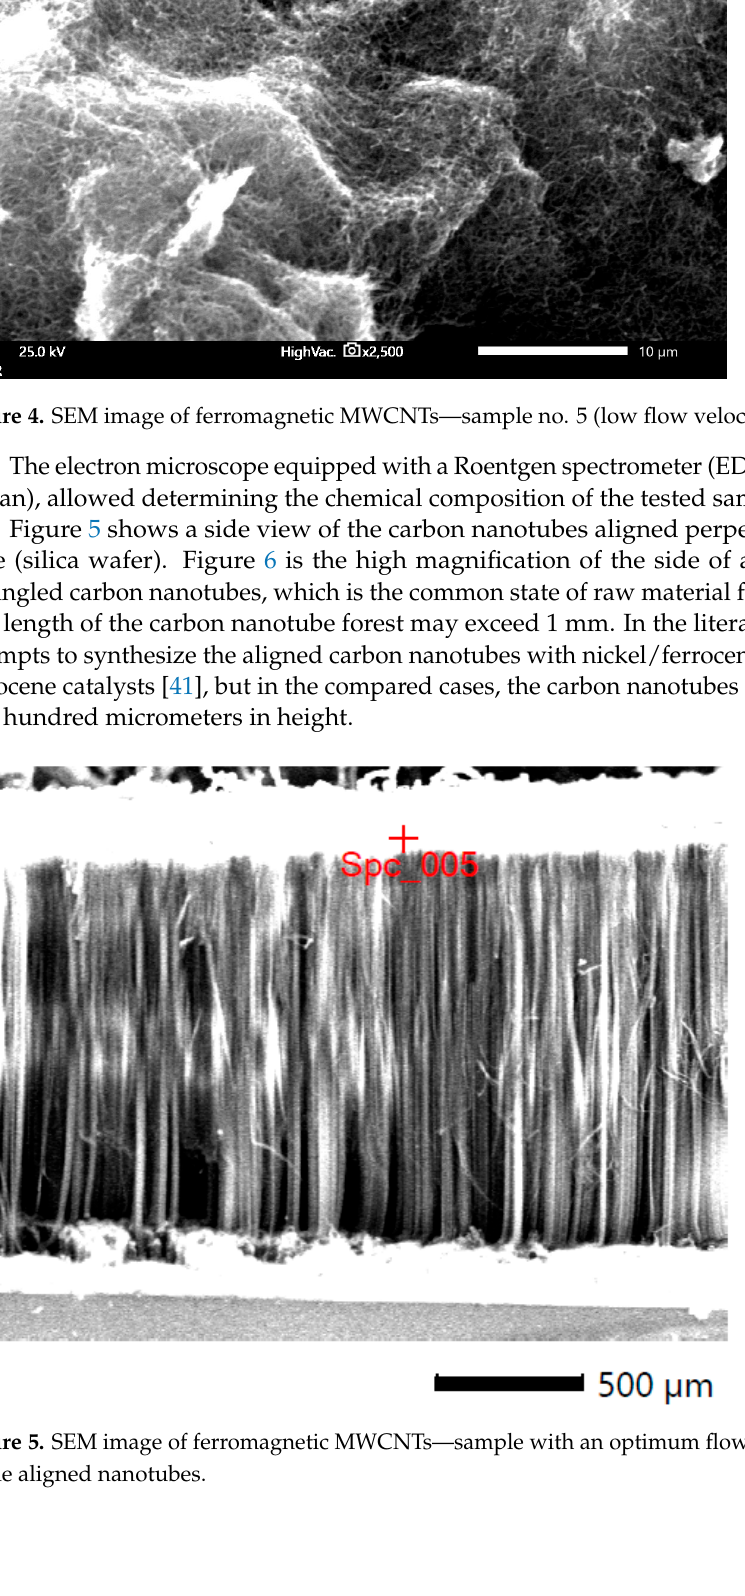
Figure 6. EDS analysis of the sample with an optimum flow velocity. Side view of the aligned nanotubes. To calculate the purity of the product, an additional thermogravimetric analysis was conducted (Figures 7 and 8).